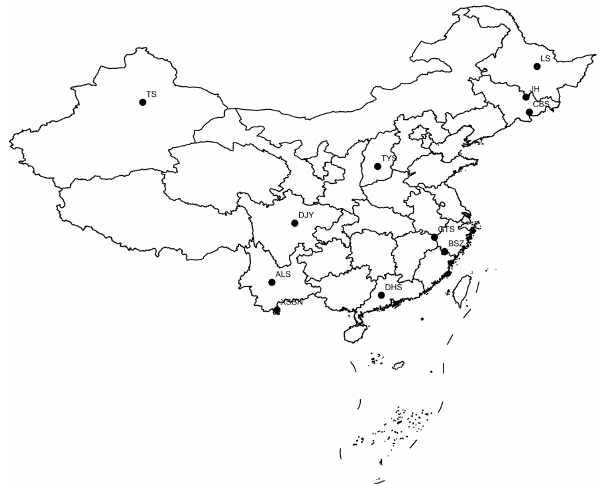
Fig. 1. Locations of the 11 forest plots: Liangshui (LS), Jiaohe (JH), Changbaishan (CBS), Taiyueshan (TYS), Dujiangyan (DJY), Ailaoshan (ALS), Xishuangbanna (XSBN), Dinghushan (DHS), Gutianshan (GTS), Baishanzu